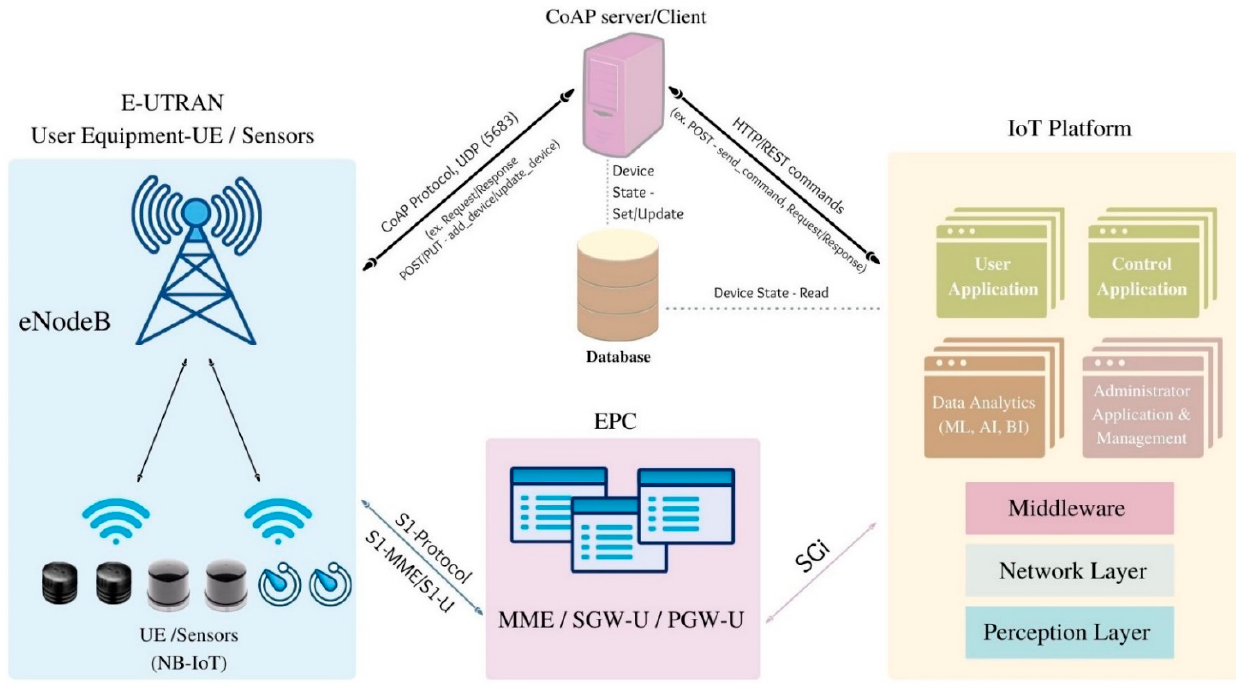
Figure 19. The proposed solution architecture has for main components: the NB-IoT sensors, IoT platform, database, and CoAP server. The EPC packet contains the communication interfaces. The proposed solution consists of the components listed below.